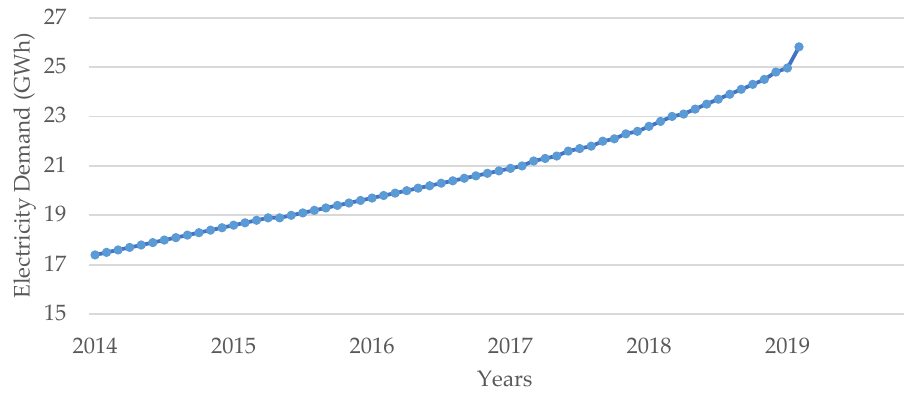
Figure 2. Electricity demand growth of Gokceada by year from 2014 to 2019.